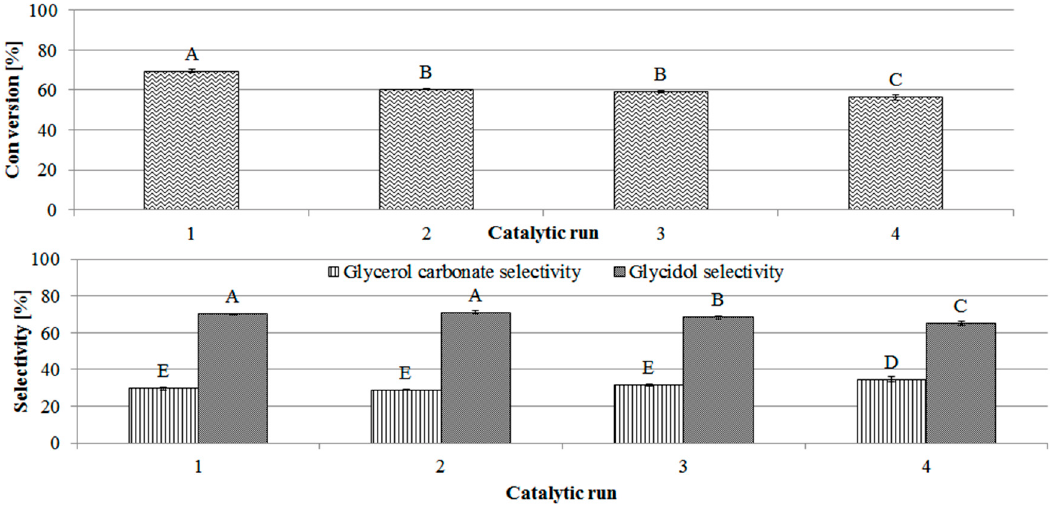
Figure 8. Recyclability of the biosolids-based catalyst. during four catalytic runs (catalyst/glycerol 9 wt %, 140 °C, urea/glycerol 2 mol/mol, air stream, 6 h) The errors represent the standard deviations calculated according to the values of three experiments. The means of triplicate experiments are reported, with the error bars representing standard deviation. Data annotated with different letters are significantly different (confidence level of 95%).